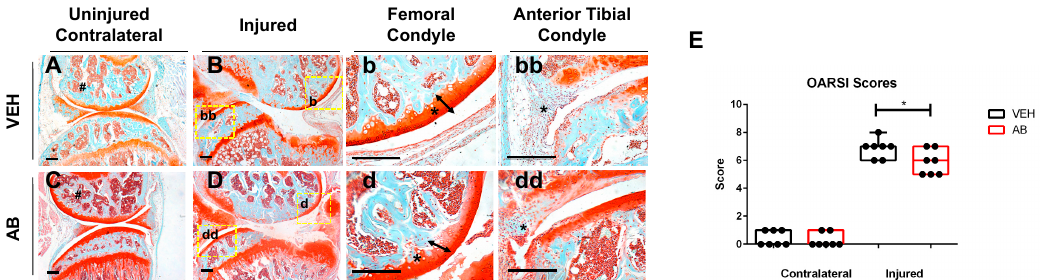
Figure 1. Characterization of post traumatic osteoarthritis (PTOA)-associated structural changes of antibiotic-treated animals in the knee. ( A ) Histological evaluation of vehicle (VEH) contralateral, ( B – bb ) VEH injured, ( C ) Antibiotic treated (AB) contralateral, and ( D – dd ) AB injured joints conducted at six weeks post injury using Safranin-O and Fast Green staining (scale bars indicate 200 mm). High magnification images corresponding to yellow boxes ( B , D ) are provided b, bb, d, dd. ( E ) PTOA severity was quantified using a modified OARSI scoring system (* p -value < 0.05).